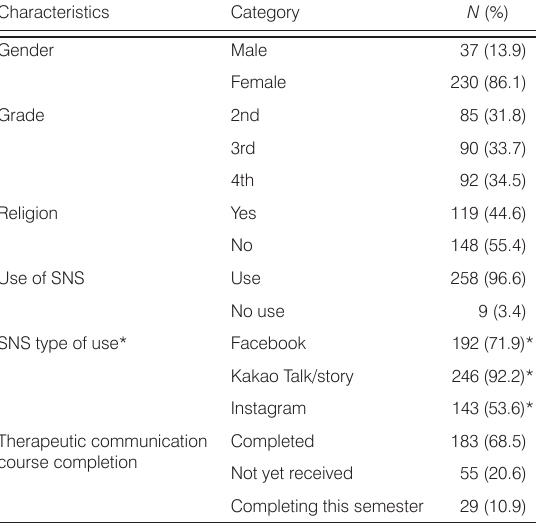
Table 1. General characteristics ( N =